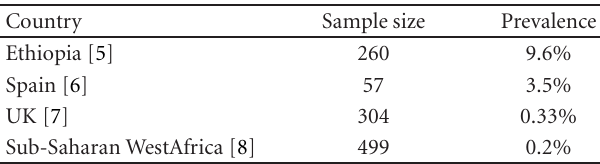
Table 1: Prevalence of HIV infection among sailors in other countries.